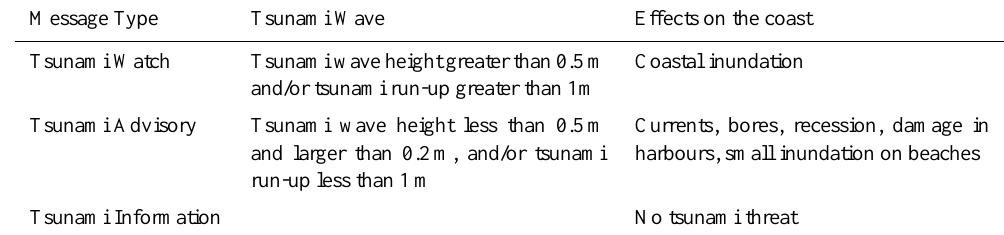
Table 4. Tsunami message types as defined by the ICG/NEAMTWS in the 2010